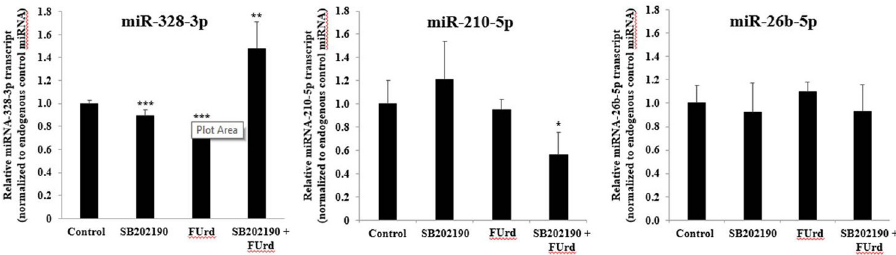
Fig 7. miRNA transcript levels in chemoresistant and SB202190-treated chemosensitive KG1a cells exposed to FUrd using RT-qPCR. The KG1a cells were non-treated or treated with 10 μ M SB202190 for 2 h incubation prior to cell treatment with 10 μ M FUrd. After 48 h incubation, the total RNA was extracted for the miRNA RT-qPCR assay. The bar graphs show the relative expression level of miR-328-3p, miR-210-5p and miR-26b-5p mRNA determined by RT-qPCR analysis in non-treated and treated KG1a cells calculated as a ratio of the expression to the endogenous control miRNA. The results are presented as mean ± SD of three independent experiments. � p < 0.05, �� p < 0.01, and ��� p < 0.001 vs .